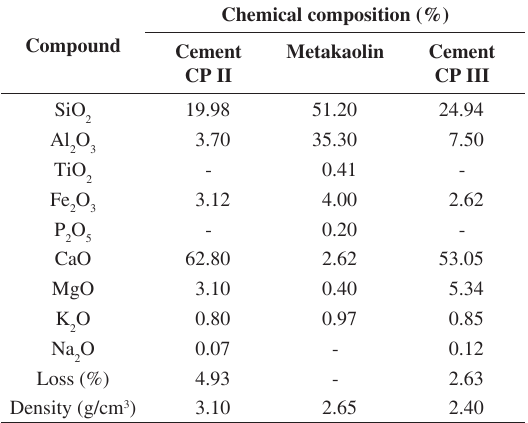
Table 1. Chemical composition and density of the used binders.